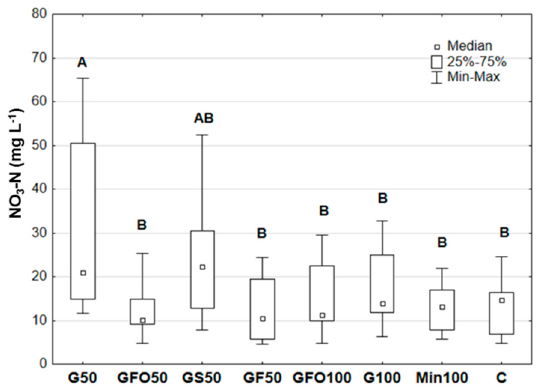
Figure 6. Nitrate nitrogen concentration in percolation water during the sunflower growing season. Di ff erent letters among treatments indicate significant di ff erences according to the Kruskal-Wallis test, p < 0.05. G50: 50% of N from G compost and 50% of N from mineral fertilization (MF). GFO50: 50% of N from G + F + O compost and 50% of N from MF. GS50: 50% of N from G + S compost and 50% of N from MF. GF50: 50% of N from G + F compost and 50% of N from MF. GFO100: 100% of N from G + F + O fertilization. G100: 100% of N from G compost. Min100: 100% of N from MF. C: Un-fertilized treatment.